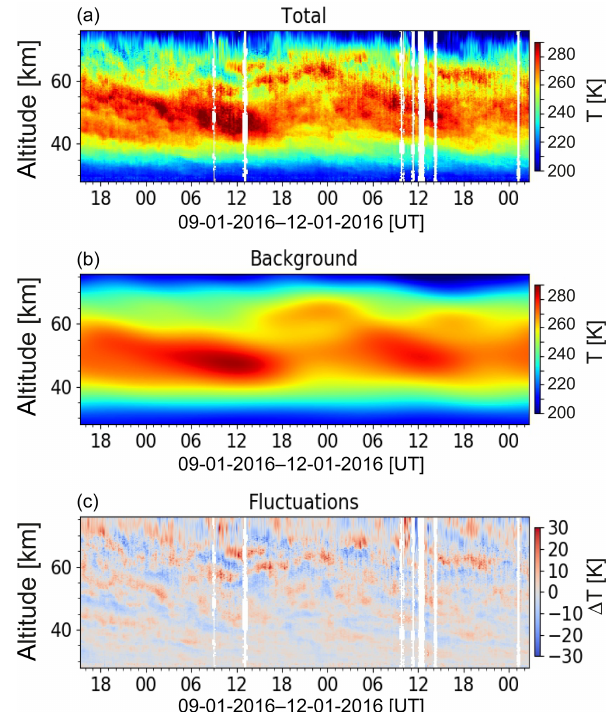
Figure 2. Temperature observations. (a) demonstrates temperature observations obtained from 9–12 January 2016. In (b) background obtained by 2-D FFT is demonstrated. (c) shows remaining small- scale fluctuations used for GW analysis. White vertical lines repre- sent gaps in the measured